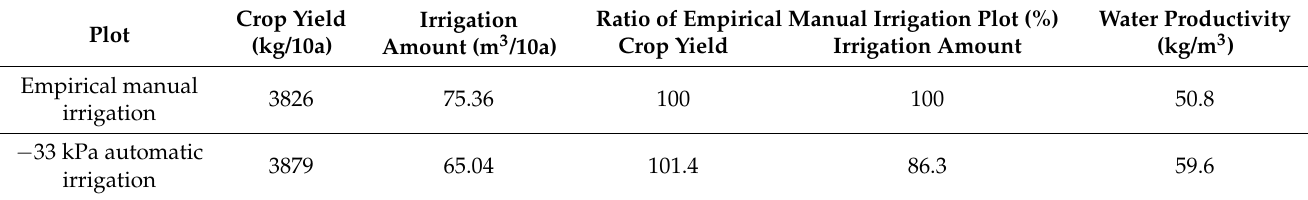
Table 3. Crop yield, irrigation amount, and water productivity by each plot in the second cropping